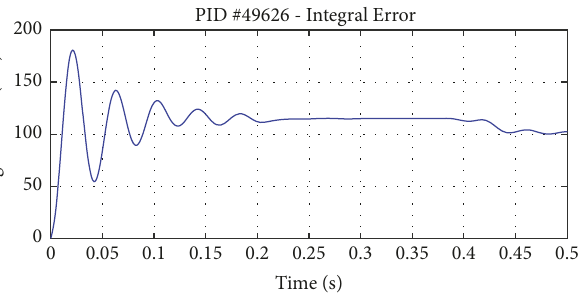
Figure 14: Sliding mode integral error (Shot #57587).